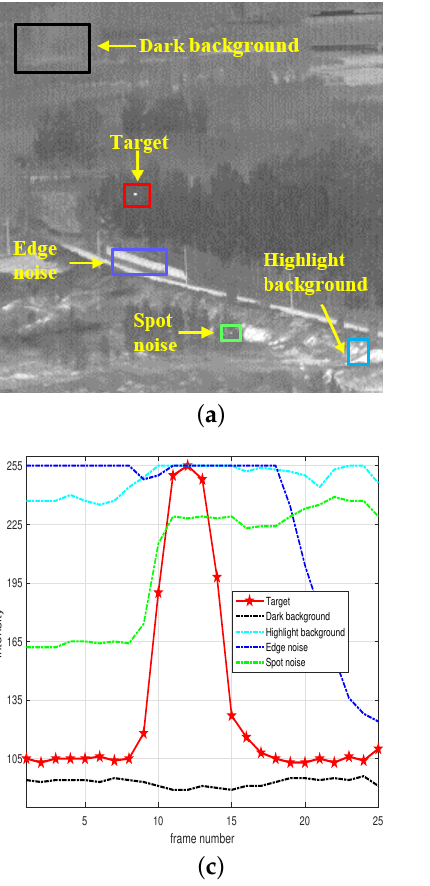
Figure 12. The intensity curves for different types of pixels in the time domain; ( a ) is a typical infrared image and different colors mark different pixel areas, ( b ) is the sequence information, and ( c ) is the temporal intensity